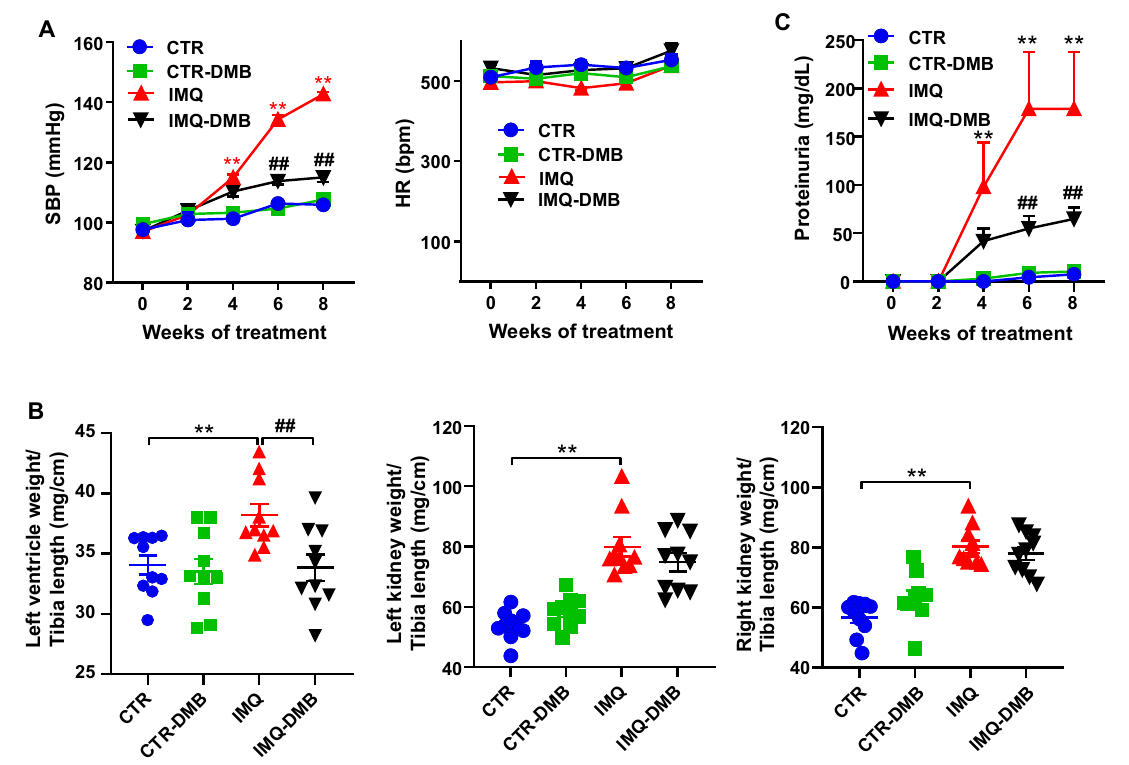
Figure 1. Effects of 3,3-dimethyl-1-butanol (DMB) treatment on blood pressure, organ morphology, and proteinuria in control (CTR) and imiquimod (IMQ) mice. ( A ) Systolic blood pressure (SBP) as determined by tail-cuff plethysmography; ( B ) morphology data as organ weigh/tibia length ratios; and ( C ) proteinuria in CTR, CTR-group treated with DMB (CTR-DMB), IMQ, and IMQ-group treated with DMB (IMQ-DMB). The data are expressed in a means ± SEM format. Tail SBP and proteinuria were tested by two-way ANOVA with the Tukey’s multiple comparison test. The morphological variables were tested with one-way ANOVA and Tukey’s post hoc test, or Kruskal–Wallis test with Dunn’s multiple comparisons. ** p < 0.01 in comparison with CTR; ## p < 0.01 in comparison with IMQ.